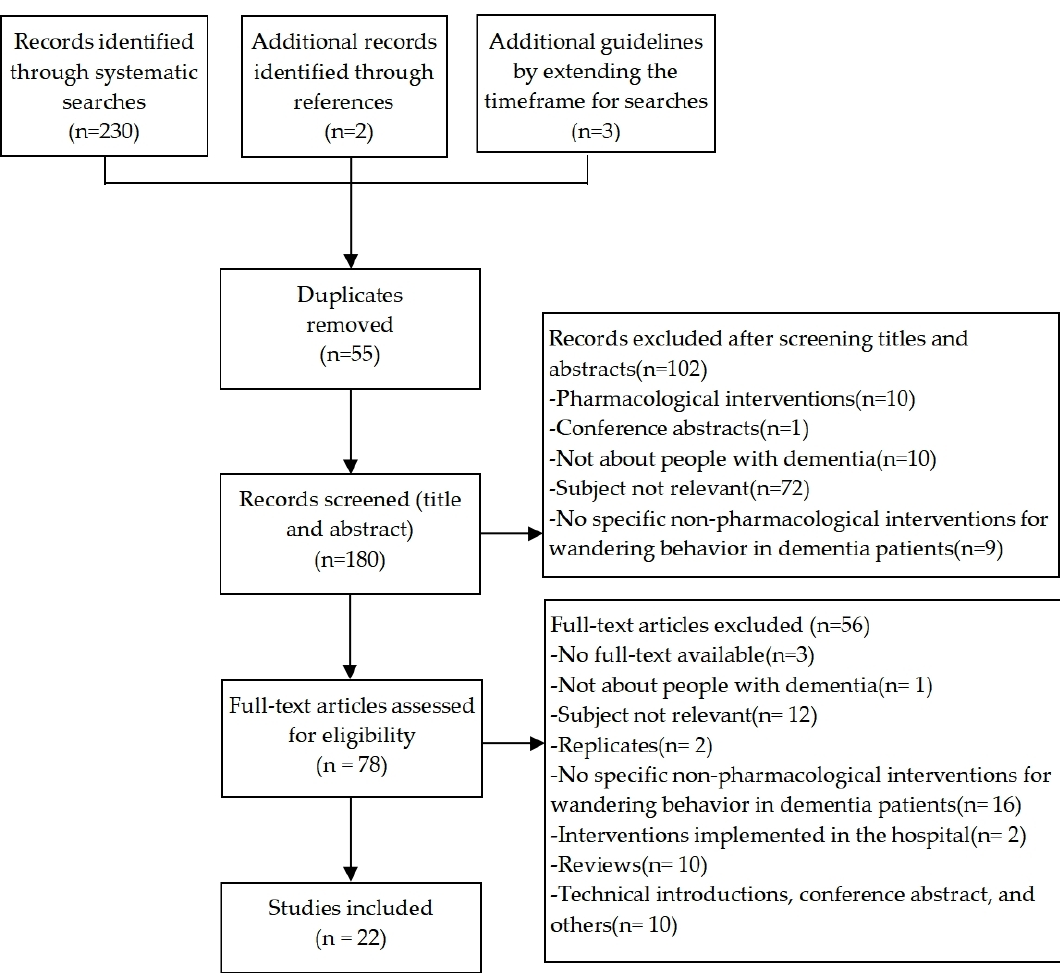
Figure 1. PRISMA flow diagram of the search process.